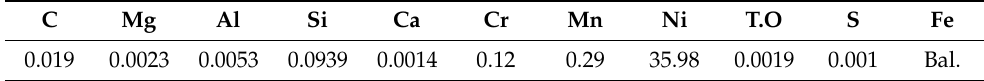
Table 1. Chemical composition of the alloy used in experiments, wt%.